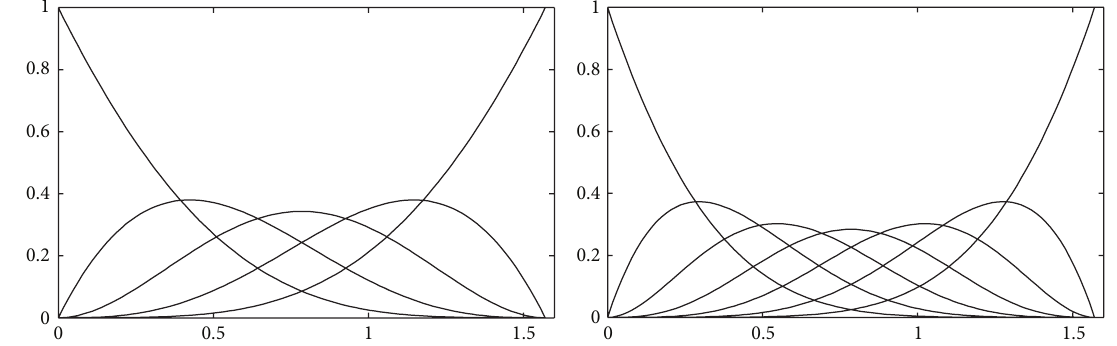
Figure 1: Trigonometric basis functions with 𝑛 = 2 and 𝑛 = 3